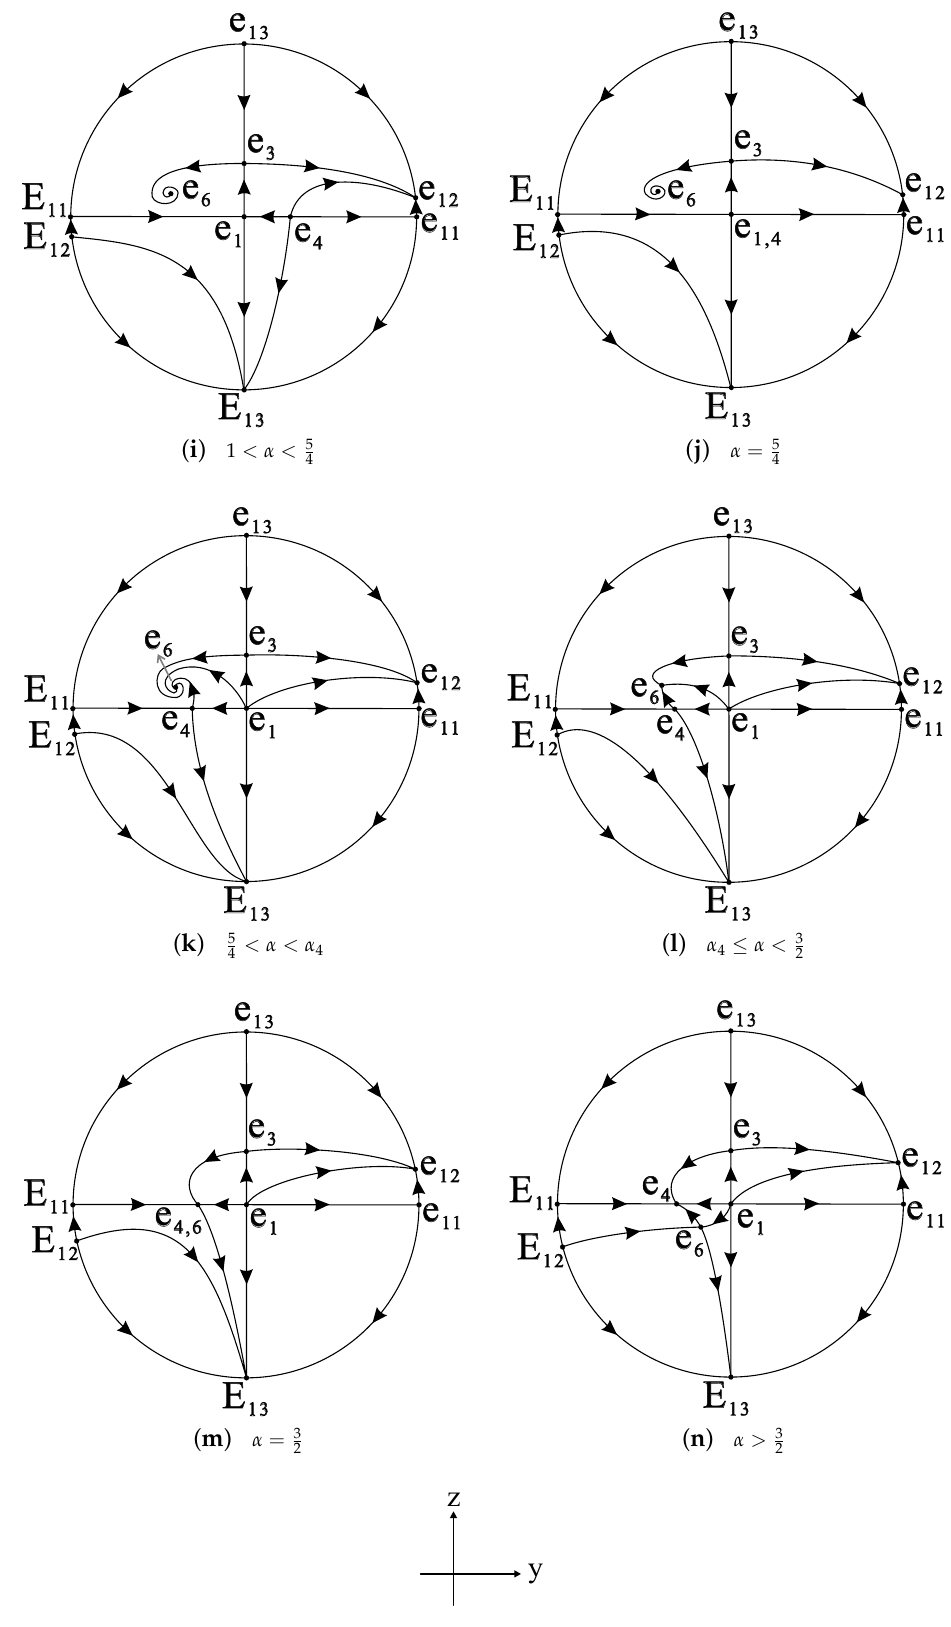
Figure 4. ( a – n ) Phase portraits on 1 − x + ( α − 1 ) y − z =